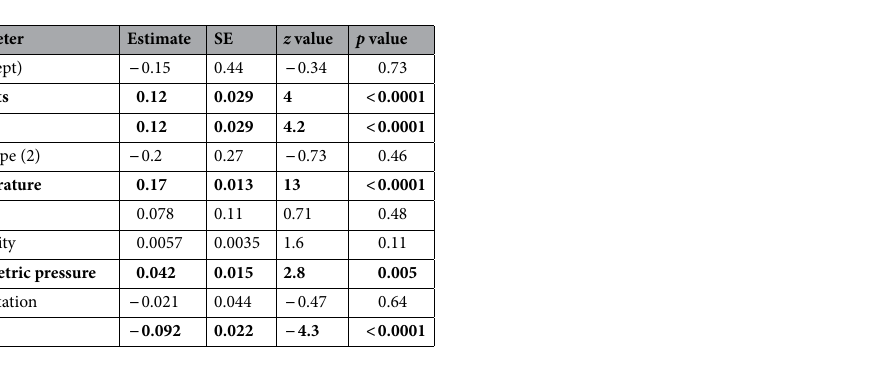
Table 3. β coefficients (in log e units) for variables affecting cave-exiting activity in 9 caves during winter for western small-footed myotis from 2011 to 2018 in southeastern Idaho, USA. Significant parameters are